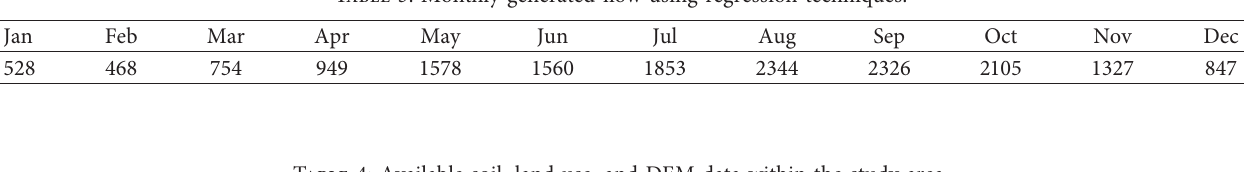
Table 3: Monthly generated flow using regression techniques.